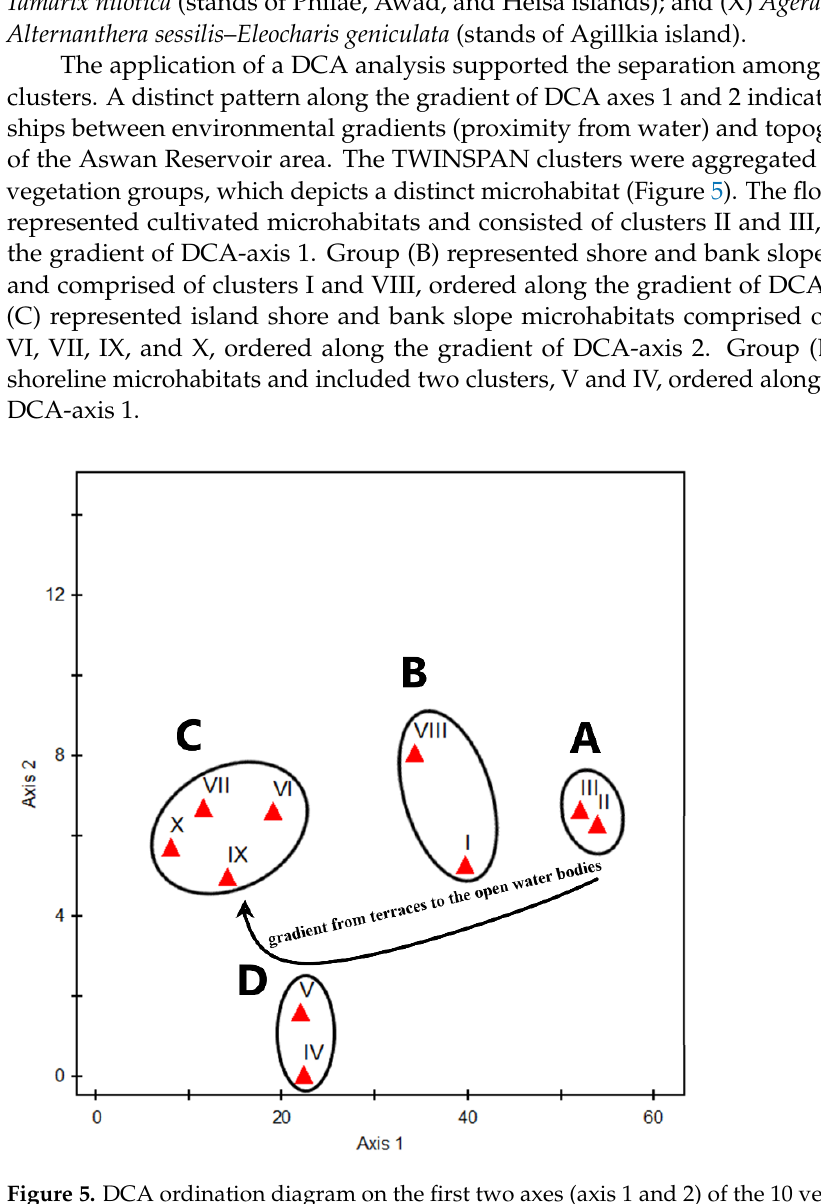
Figure 5. DCA ordination diagram on the first two axes (axis 1 and 2) of the 10 vegetation clusters (red triangles) identified after the application of TWINSPAN on the 27 sampled stands in the Aswan Reservoir area.